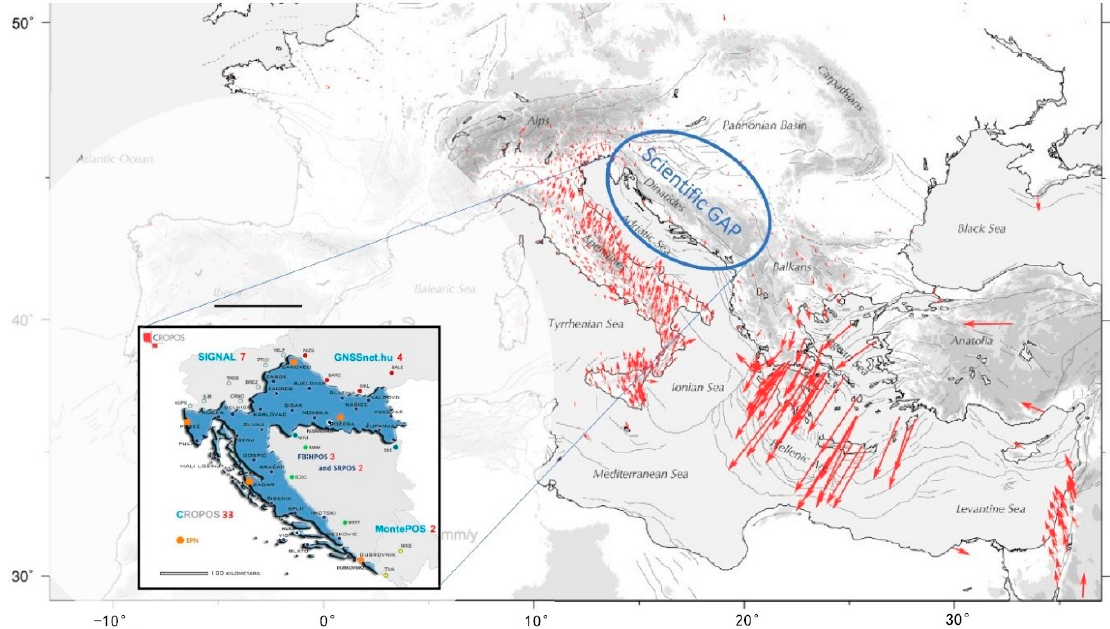
Figure 1. Low coverage of GNSS-derived velocities in the area of the Republic of Croatia represents a scientific gap (modified from